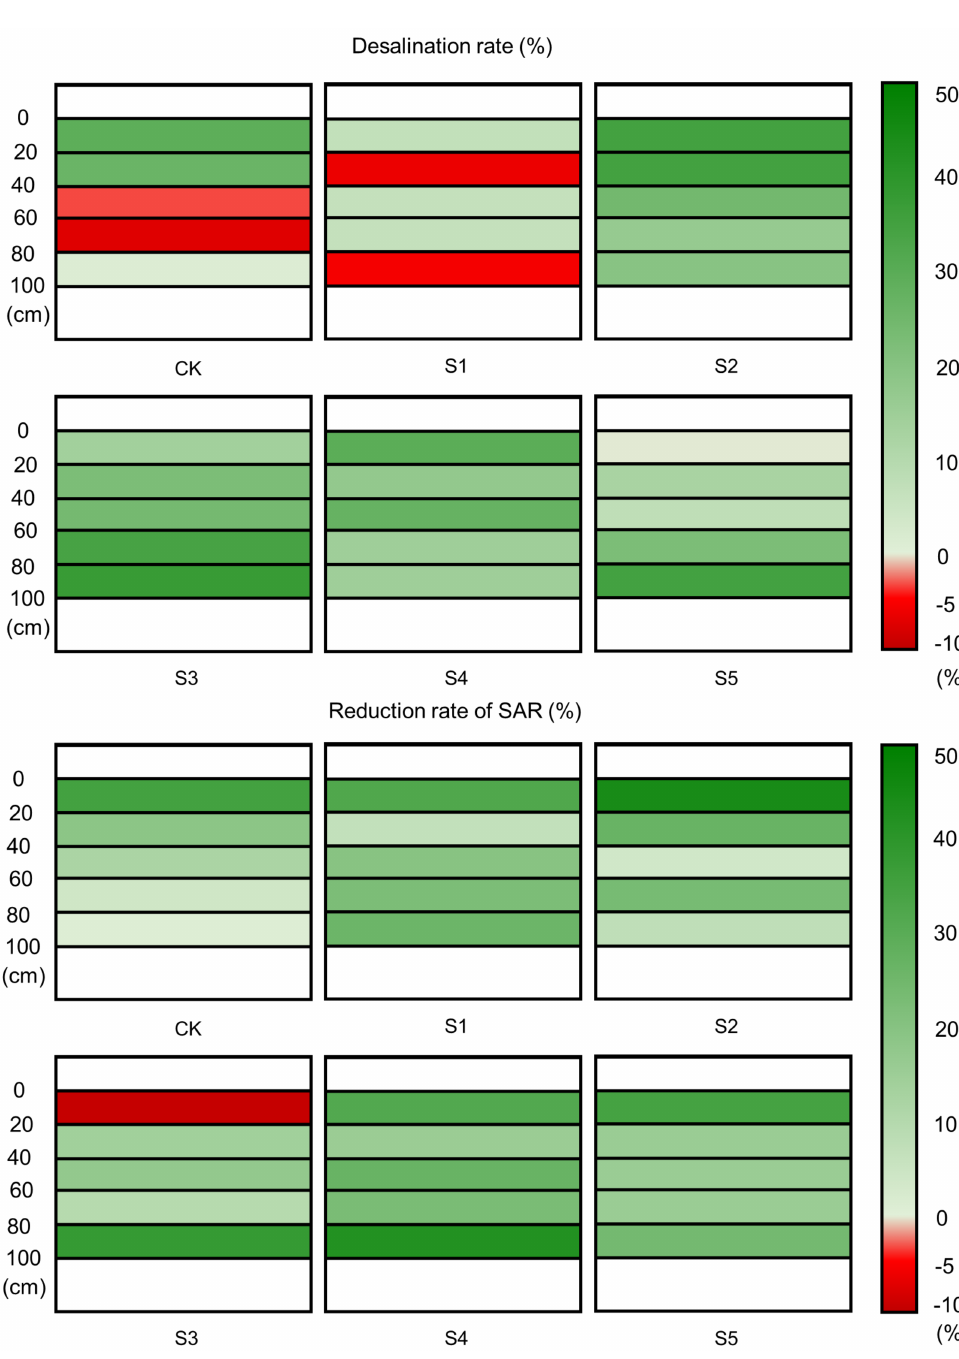
Figure 9. The soil desalination rate and reduction rate of SAR at different soil depths. SAR refers to sodium adsorption